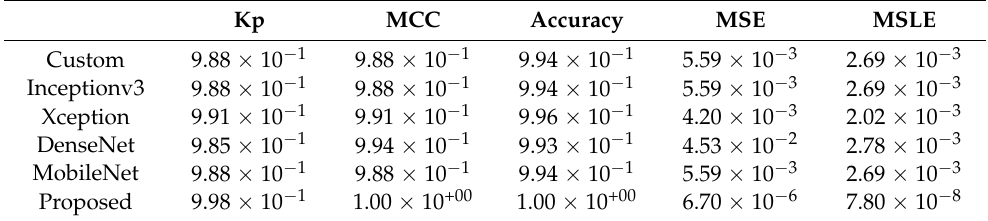
Table 4. The classification report for each of the models and the final model using the casting dataset. Kp MCC